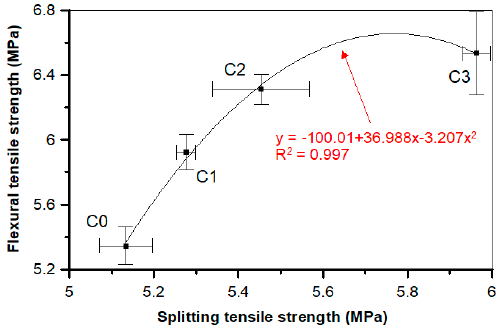
Figure 20. Relationship between the splitting tensile and flexural tensile strengths of a concrete.